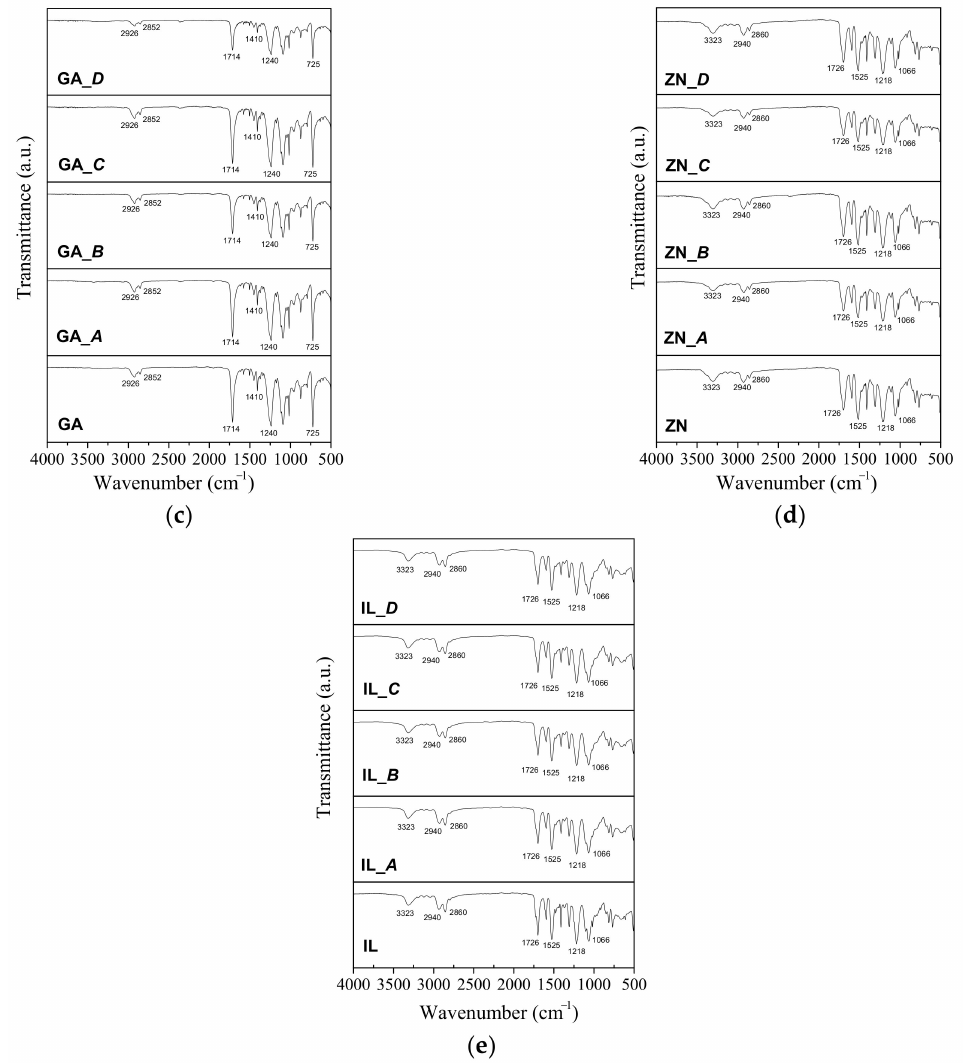
Figure 8. Comparison between the FTIR spectra of the as-received aligners and those immersed for 14 days into staining agents. ( a ) Erkodur as received (EK) and after exposure to artificial saliva (EK_ A ), nicotine (EK_ B ), red wine (EK_ C ) and coffee (EK_ D ); ( b ) Essix Plastic as received (EP) and after exposure to artificial saliva (EP_ A ), nicotine (EP_ B ), red wine (EP_ C ) and coffee (EP_ D ); ( c ) Ghost Aligner as received (GA) and after exposure to artificial saliva (GA_ A ), nicotine (GA_ B ), red wine (GA_ C ) and coffee (GA_ D ); ( d ) Zendura as received (ZN) and after exposure to artificial saliva (ZN_ A ), nicotine (ZN_ B ), red wine (ZN_ C ) and coffee (ZN_ D ); ( e ) Invisalign as received (IL) and after exposure to artificial saliva (IL_ A ), nicotine (IL_ B ), red wine (IL_ C ) and coffee (IL_ D